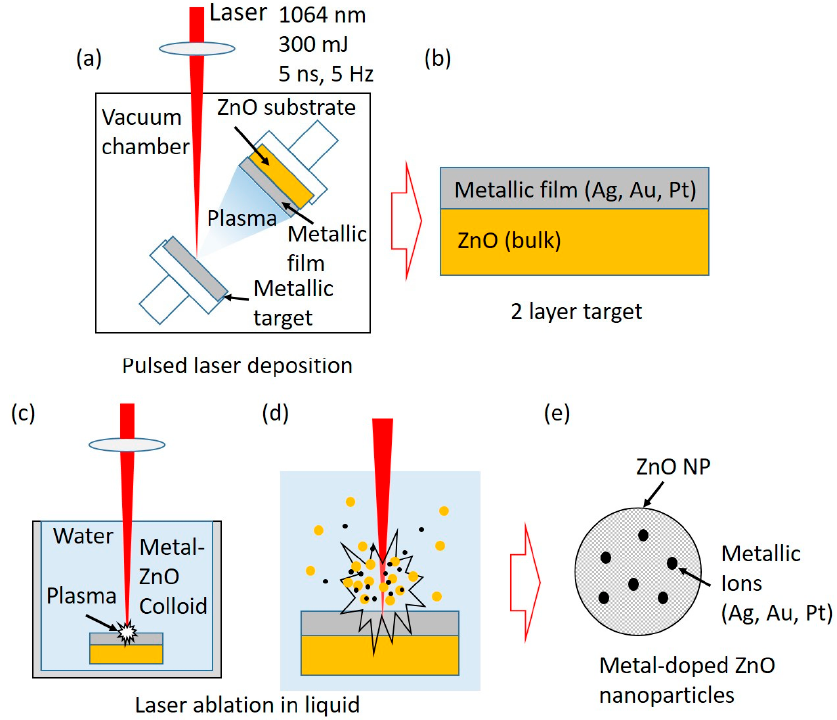
Figure 1. Two-step synthesis method of Ag, Au, and Pt-doped ZnO nanoparticles. First step is ( a ) pulsed laser deposition (PLD) of Ag, Au, and Pt on the ZnO substrate. As result, ( b ) a two-layered target (ZnO-metallic film) is formed. In the second step, ( c , d ) a two-layer target is ablated in water, forming ( e ) Ag, Au, and Pt-doped ZnO